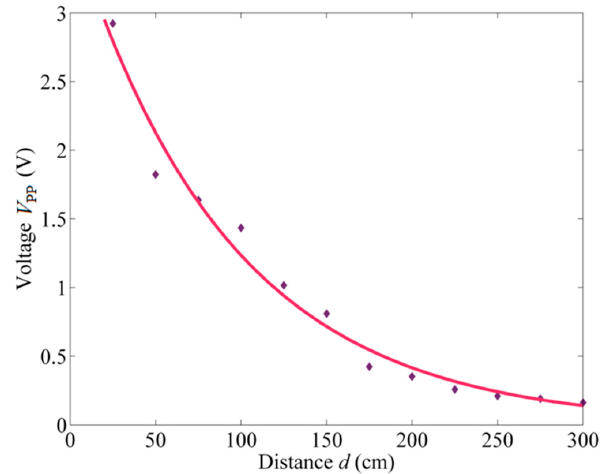
Figure 7. Ultrasonic signals detected at different linear distances.